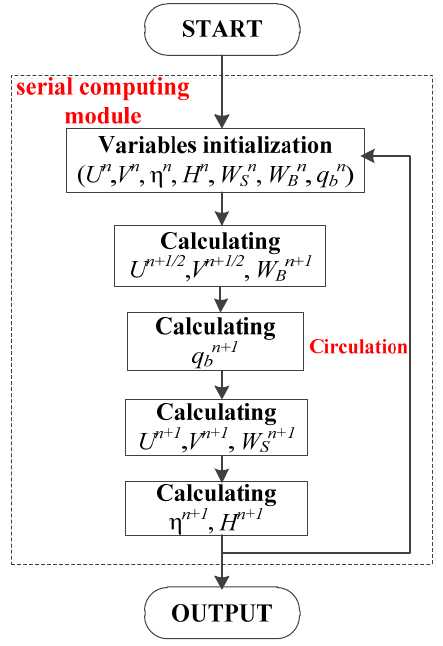
Figure 2. Solution steps of the non-hydrostatic model (serial computing).